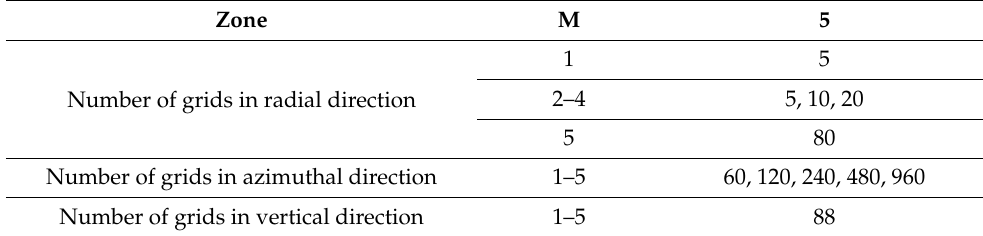
Table 1. Grid arrangement in zonal grids in the computational domain.